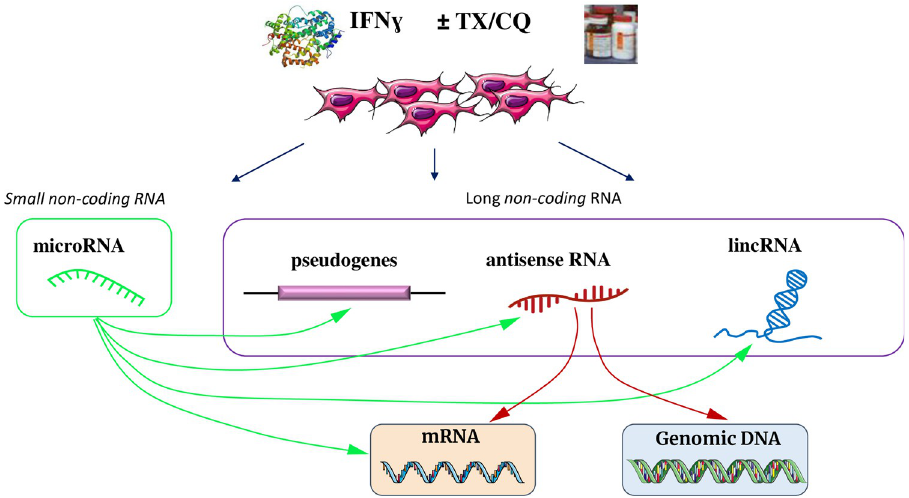
Fig 1. Major interactions between non-coding RNAs, mRNA and DNA. Interactions of these molecular species with proteins are omitted for